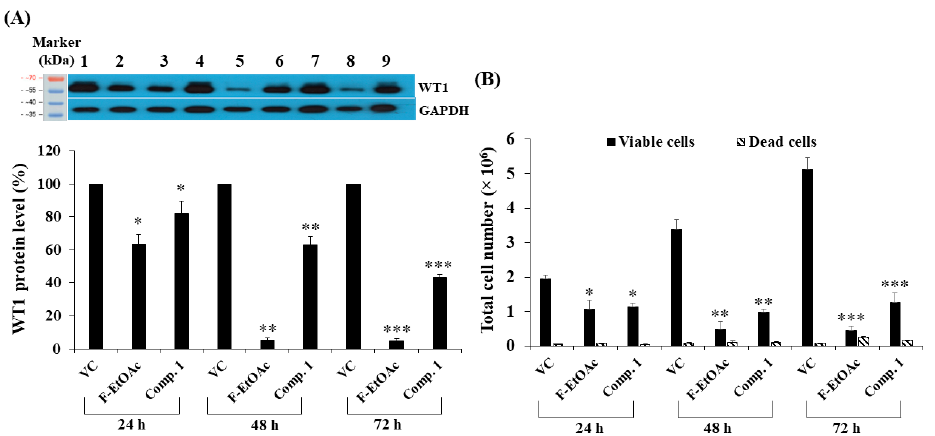
Figure 9. Effect of F-EtOAc and compound 1 on WT1 protein expression in KG-1a cells. ( A ) The levels of WT1 protein following treatments with F-EtOAc (4.58 µg/mL) and compound 1 (comp.1; 2.30 µg/mL) for 24, 48, and 72 h. Protein levels were evaluated using Western blotting and analysed using a scanning densitometer. The levels of WT1 were normalised using GAPDH protein levels. WT1 and GAPDH proteins following vehicle control at 24 h (No. 1), F-EtOAc at 24 h (No. 2), compound 1 at 24 h (No. 3), vehicle control at 48 h (No. 4), F-EtOAc at 48 h (No. 5), compound 1 at 48 h (No. 6), vehicle control at 72 h (No. 7), F-EtOAc at 72 h (No. 8), and compound 1 at 72 (No. 9). ( B ) Total cell number following treatment with F-EtOAc and compound 1 for 24, 48, and 72 h. Total cell numbers were determined using the trypan blue exclusion method. Each bar represented mean ± SD of three independent experiments performed in triplicate. Asterisk (*) denotes significant differences from the vehicle control; * p < 0.05; ** p < 0.01; *** p < 0.001.